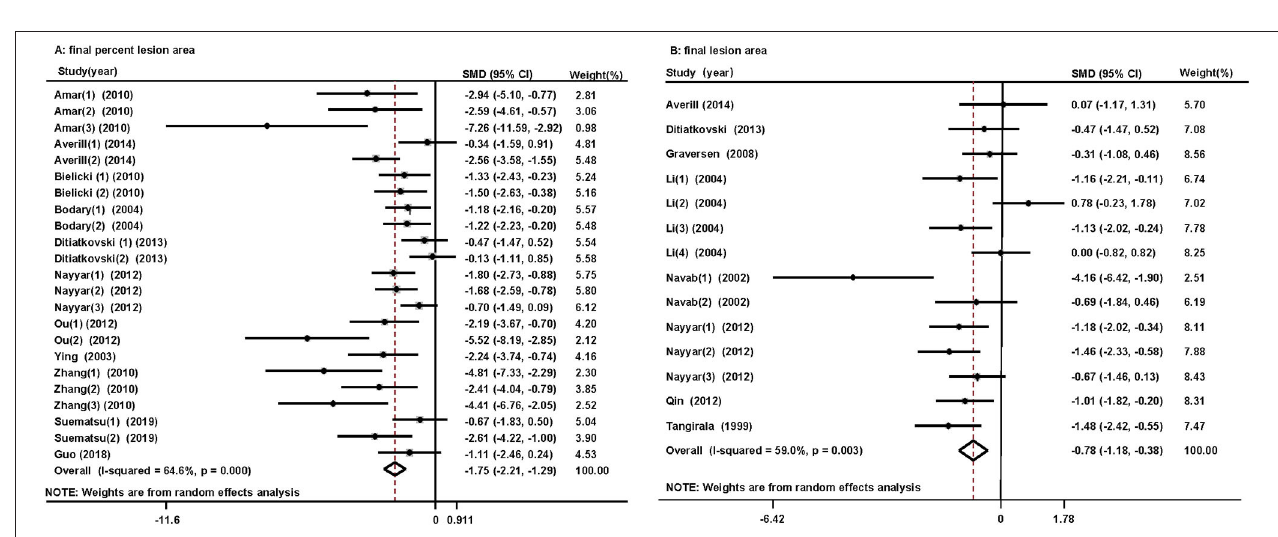
FIGURE 3 | Forest plots of the meta-analysis of the associations between final percent lesion area (A) , final lesion area (B) in arteries, and HDL/apoA-1 replacement therapy administration in mice using a random-effects model. SMD, standardized mean difference; CI, confidence interval. This result shows that HDL/apoA-1 replacement therapies significantly decreased the final percent lesion area and final lesion area in mice with coronary atherosclerosis.